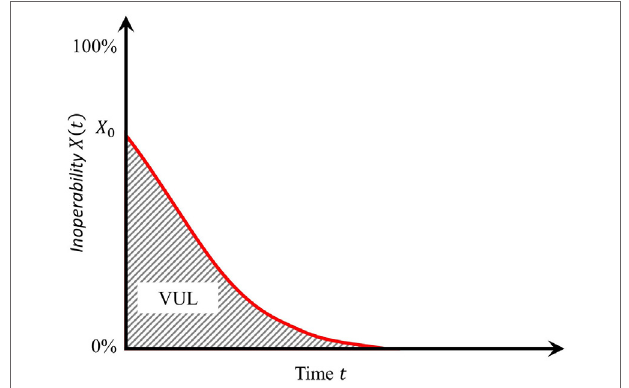
FigUre 3 | Inoperability function with the VUL